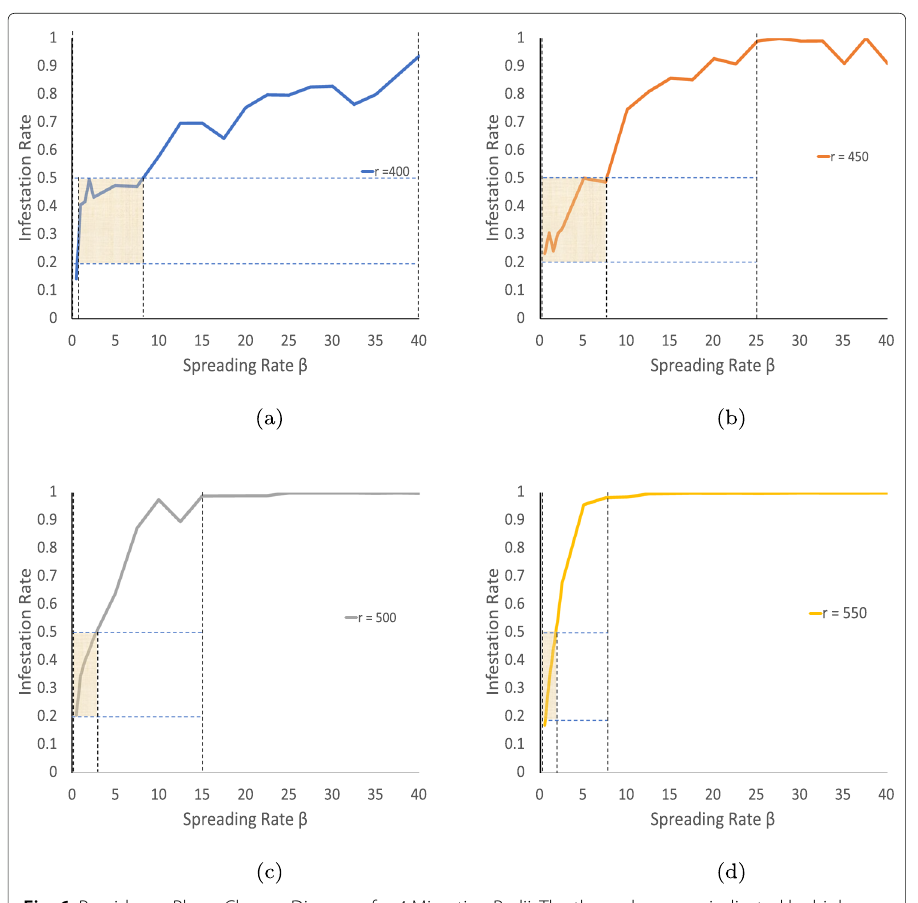
Fig. 6 Providence Phase Change Diagrams for 4 Migration Radii. The three phases are indicated by high dotted dividing lines. The true spreading rate β is unknown. If true infestation rates fall within 20% to 50%, the range of possible real-life β values is shown by the shaded region. a r = 400. b r = 450. c r = 500. d r =